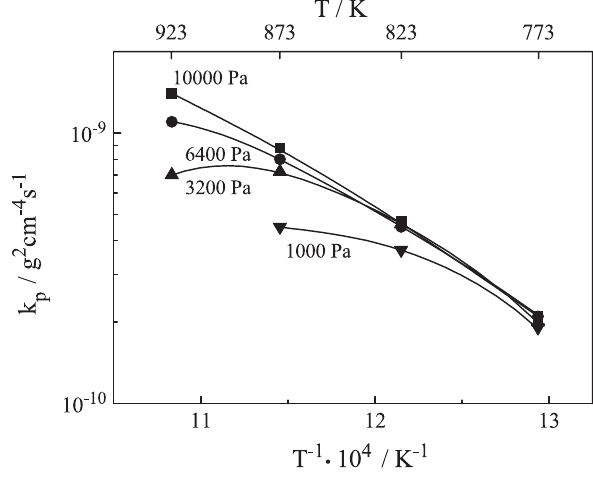
Fig. 12: The temperature dependence of the parabolic rate constant of NiS sulphidation, presented in Arrhenius plot for several sulphur vapor